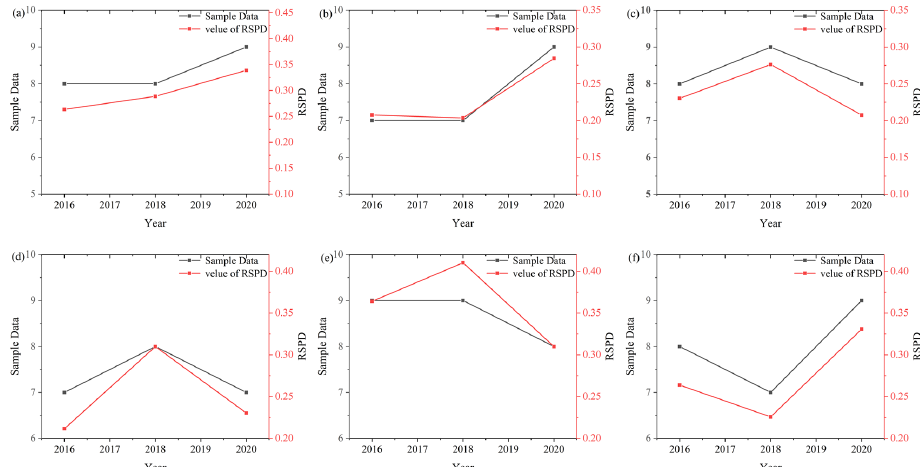
Figure 11. Time series changes of sample data and RSPD results (( a – c ) are the comparison results at sample points 3, 11 and 17, respectively, in Case I. ( d – f ) are the comparison results at sample points 7, 13 and 19, respectively, in Case II).Finally, we compared the RSPD and CV with the visual interpretation samples and the results are shown in Figure 12. It can be intuitively seen from the figure that the correlation coefficients between the RSPD and sample data are usually higher than that of the